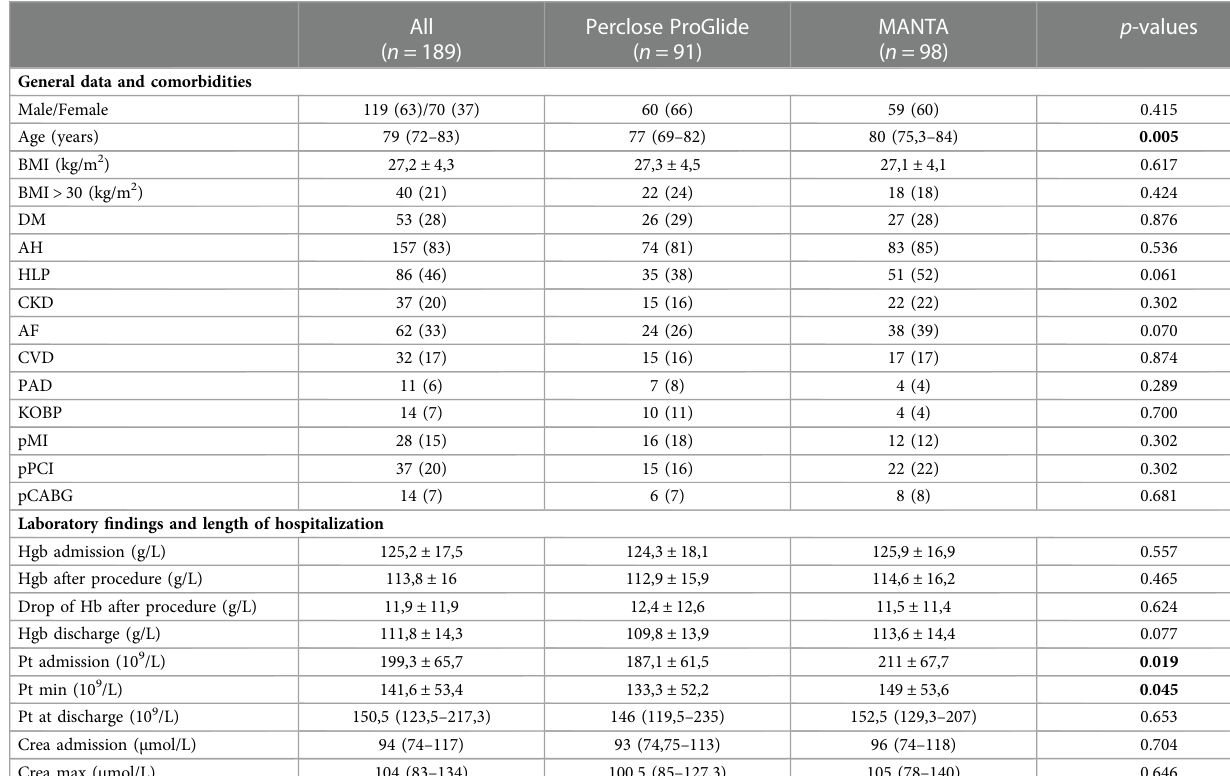
TABLE 2 Clinical and procedural